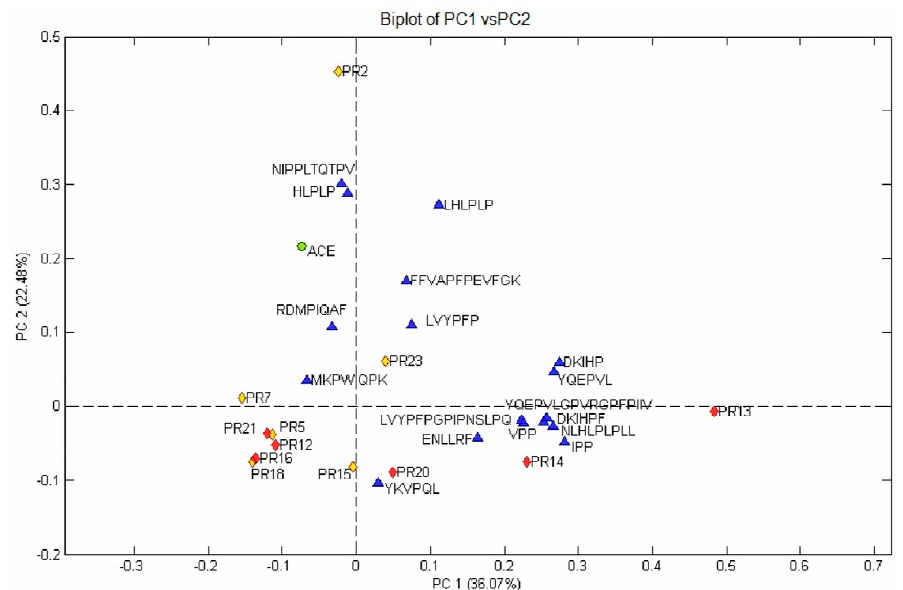
Figure 4. Distribution of peptides characterized by angiotensin-converting enzyme (ACE) inhibitory IC 50 values lower than 300 µmol/L along with principal components 1 (PC1) and 2 (PC2). IC 50 represent the concentration of peptide able to inhibit the enzymatic activity by 50%. Yellow diamonds represent LL class samples, red diamonds represent HH class samples, green circle represents the biological activity (ACE-inhibition), and blue triangles represent the bioactive peptides.